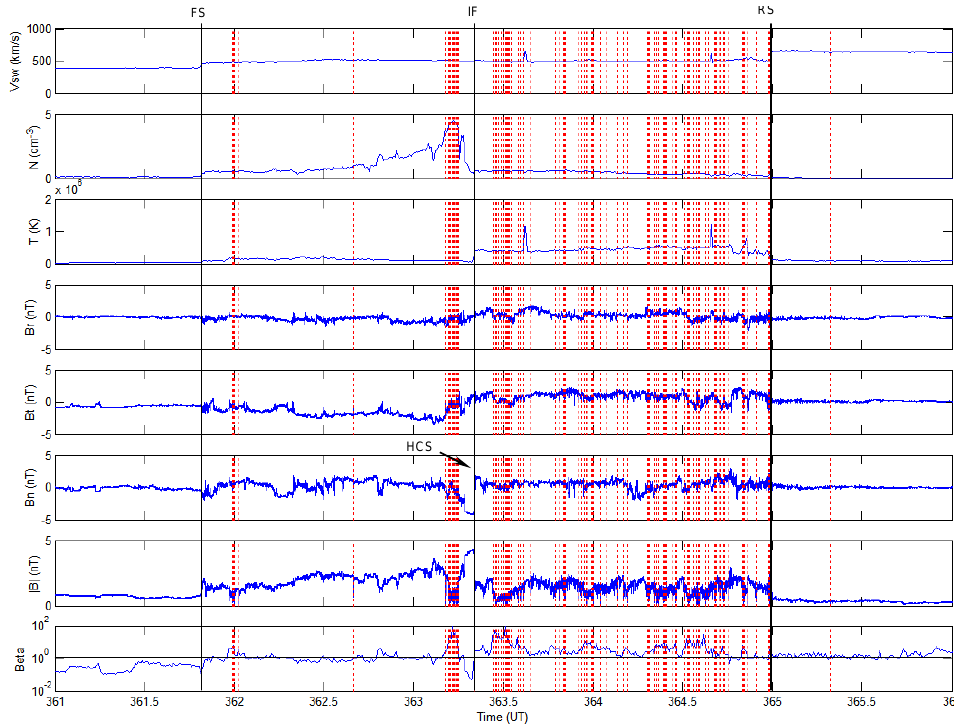
Fig. 6. CIR 8d shown in high resolution. The CIR is bounded by a fast forward shock (FS) and a fast reverse shock (RS). The interface (IF) is noted by a solid vertical line. Each MD identified by the IMDAD code is indicated by a dashed vertical